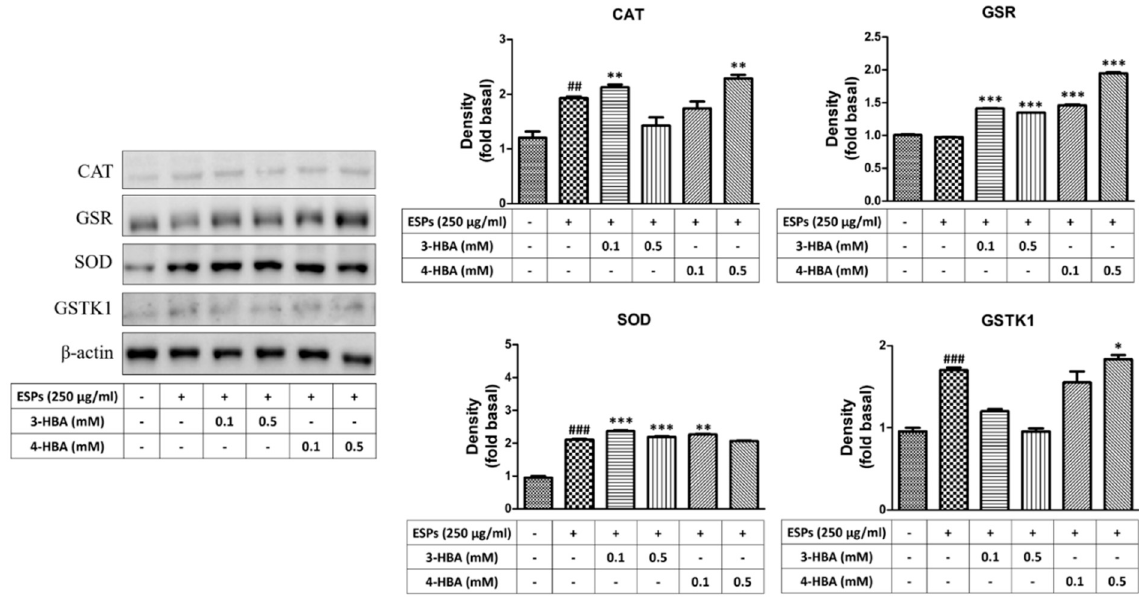
Figure 6. 3-HBA and 4-HBA induced the protein expression of antioxidants in ESP-treated astrocytes. Cells were pretreated with 3-HBA and 4-HBA (0.1 and 0.5 mM) for 4 h and then incubated with 250 µ g/mL ESPs for 12 h. Protein expression levels of antioxidants were detected by western blotting ( n = 3). + and - represent cells were pretreated or not with ESPs, 3-HBA or 4-HBA. ## p < 0.01, ### p < 0.001, compared to control. * p < 0.05, ** p < 0.01, *** p < 0.001, compared to cells exposed to